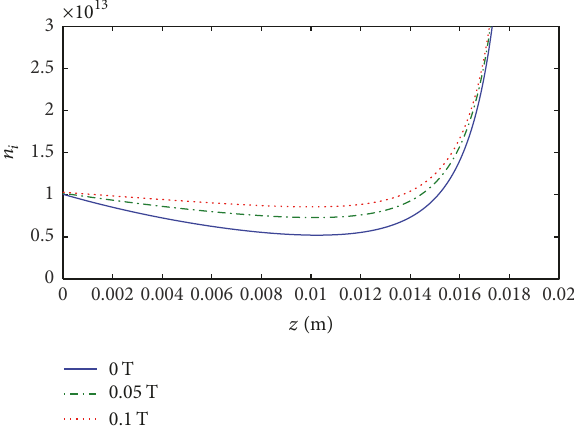
Figure 3: Axial ion density distribution under different magnetic fields.